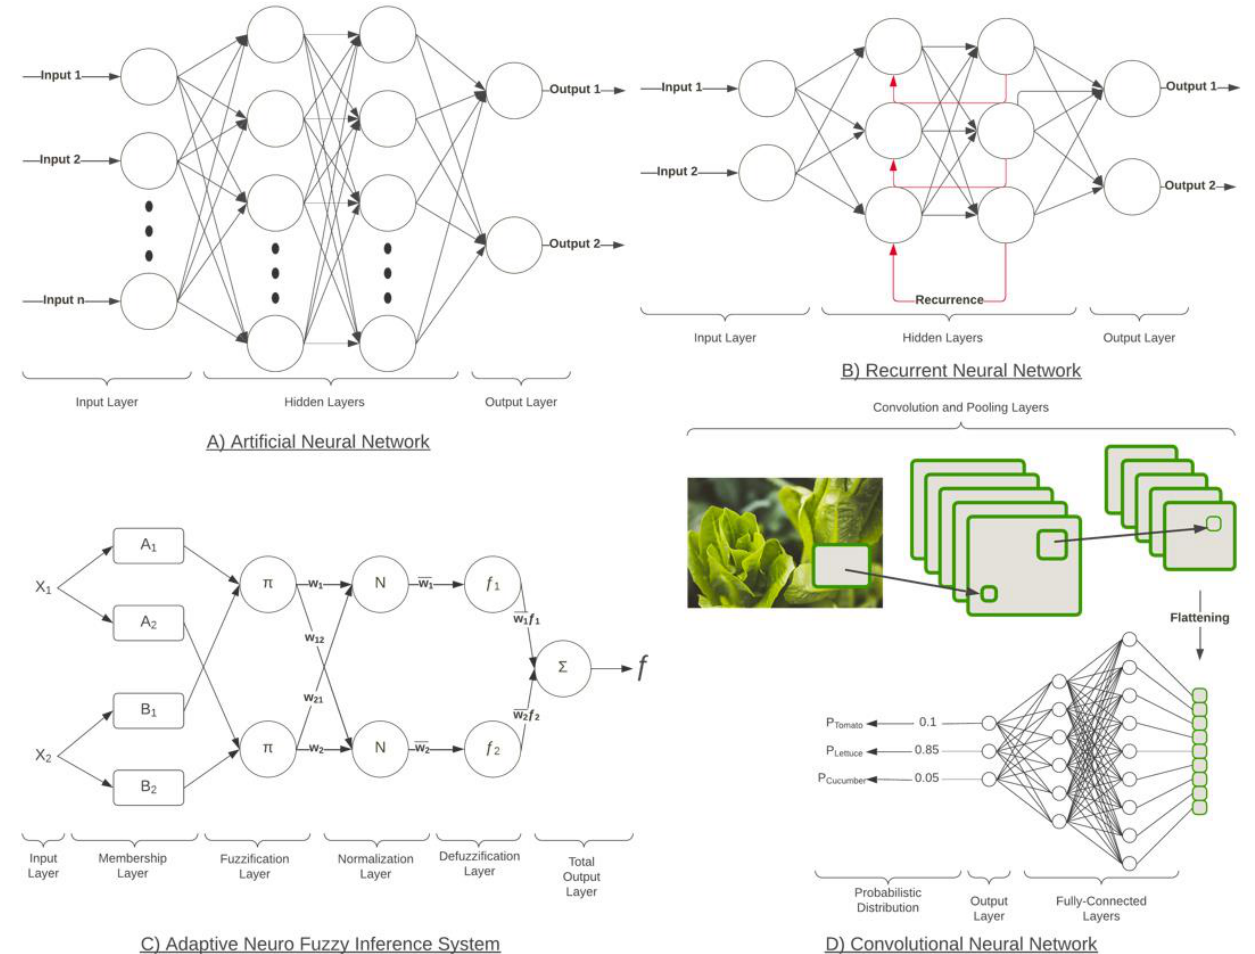
Figure 1. Four Common Neural-Network Structures in Water Treatment and Monitoring. ( A ) Four Layer Artificial Neural Network ( B ) Four Layer Recurrent Neural Network ( C ) Typical Adaptive Neuro Fuzzy Inference System Structure ( D ) Typical Convolutional Neural Network Structure